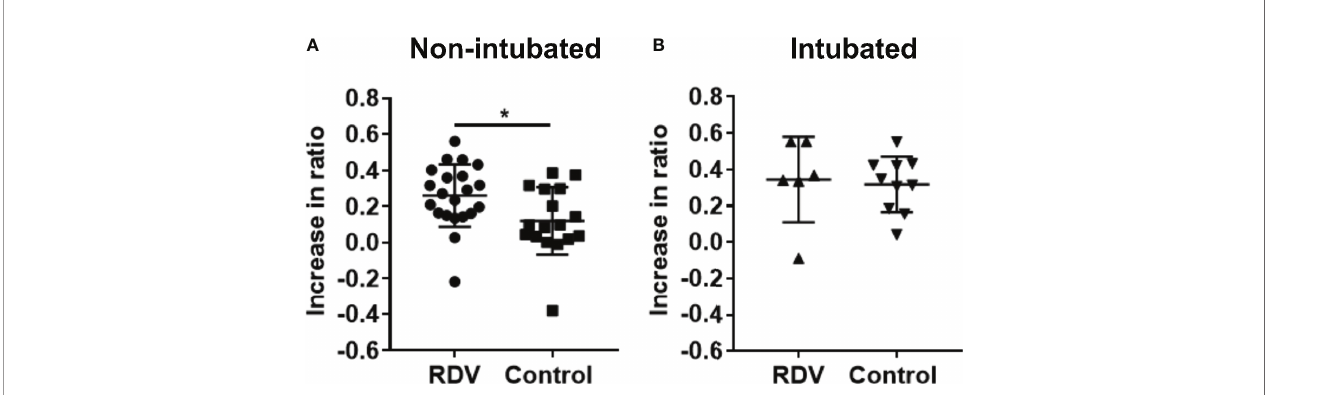
FIGURE 4 | S protein IgG subclasses responses in non-intubated or intubated patients with or without remdesivir (RDV) treatment. (A) IgG1, IgG2, IgG3, and IgG4 responses were analysed by screening plasma samples of non-intubated COVID-19 patients with RDV (n = 21) or without RDV (n = 17) treatment, and (B) intubated COVID-19 patients with RDV (n = 6) or without RDV (n = 10) treatment at 1:100 dilution against cells expressing the full-length SARS-CoV-2 spike protein, with healthy donors screened in parallel (n = 22). The ratio of combined IgG2 and IgG4 to combined IgG1 and IgG3 response (IgG 2/4 /IgG 1/3 ) in RDV-treated patients with or without intubation before and after treatment and also in non-RDV-treated patients at matched time point 1 and 2 were computed and the increase in the ratio from the fi rst to the second time point was plotted. Statistical analyses were performed with Mann Whitney U test (* P <